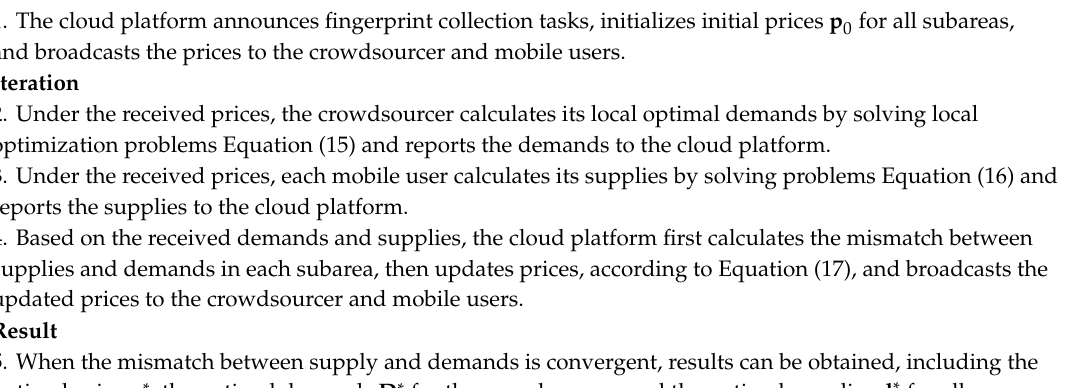
Algorithm 1: Iterative Algorithm to Search for Walrasian equilibrium